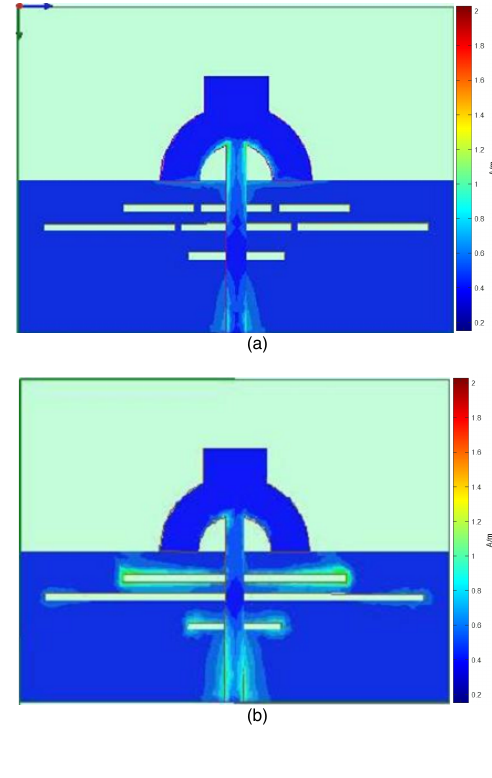
FIGURE 7. VSWR of (a) Whole band (b) Sub-band1 excited at 3.29 GHz (c) Sub-band2 excited at 3.50 GHz (d) Sub-band3 excited at 3.75GHz (e) Sub- band4 excited at